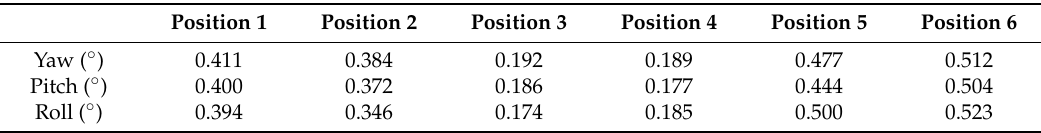
Table 5. The RMS error of cameras in different